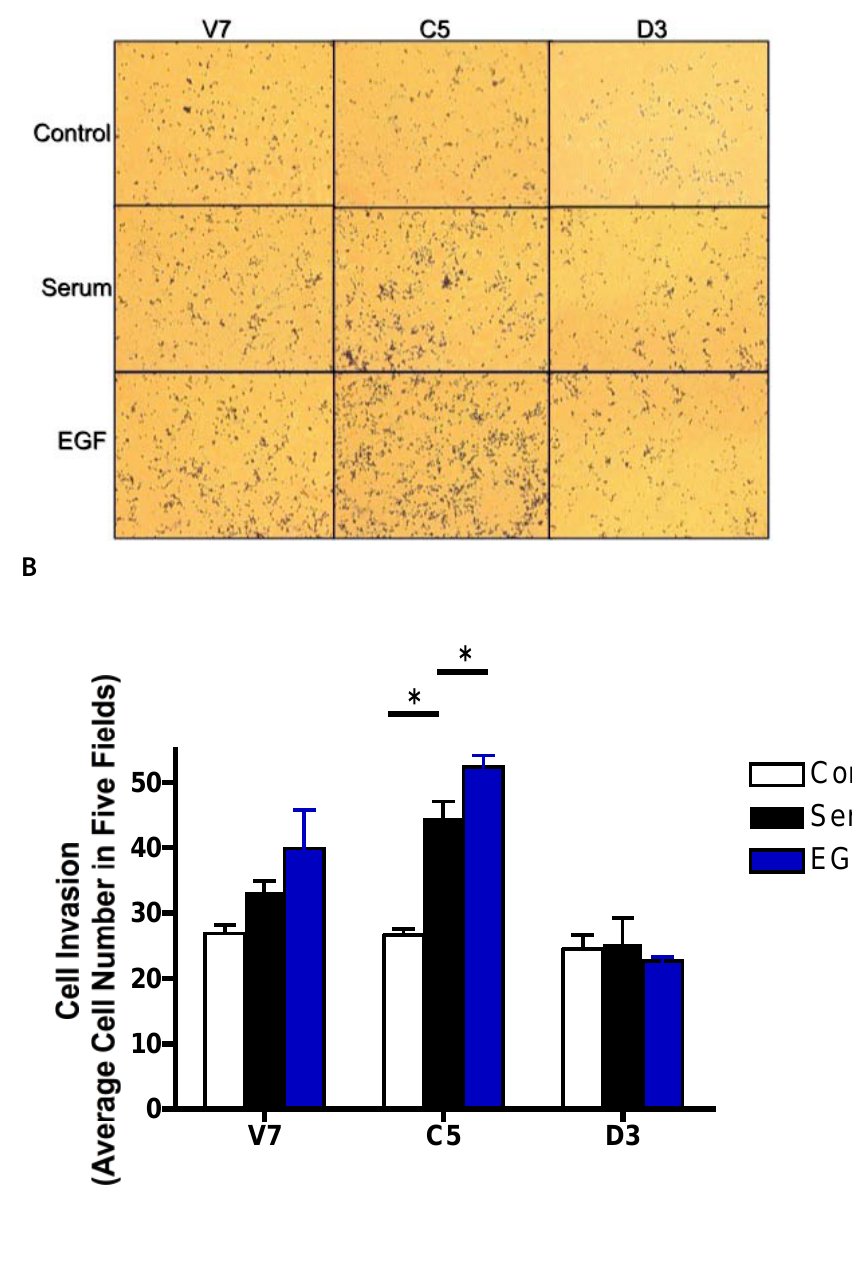
Figure 5. Effects of EGF treatment on EL4 cell invasion. Equal numbers (1 × 10 5 ) of EL4 cells were plated in the upper chamber of 8-micron trans-well insert coated with 20 µ g Matrigel. To the bottom chamber the following chemoattractants were added in serum-free medium: Control, 0.1% BSA; Serum, 10% FBS; EGF, 10 nM EGF. (a) After 24 hours, invaded cells were stained with Diff-Quik, photographed. (b) Migrated cells were quantified by cell counting. Data are plotted as percent of BSA control; each data point represents mean ± SD for three wells of cells. Statistical significance was determined using t-test: * p <